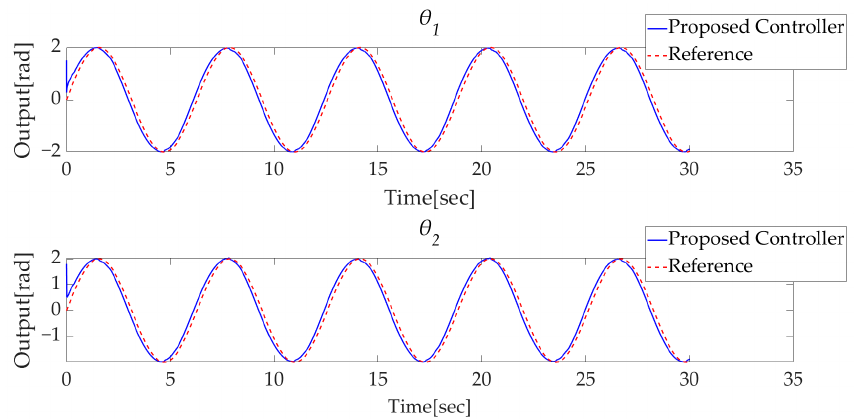
Figure 10. RT-NTMSC-NN control performance for continuous input.